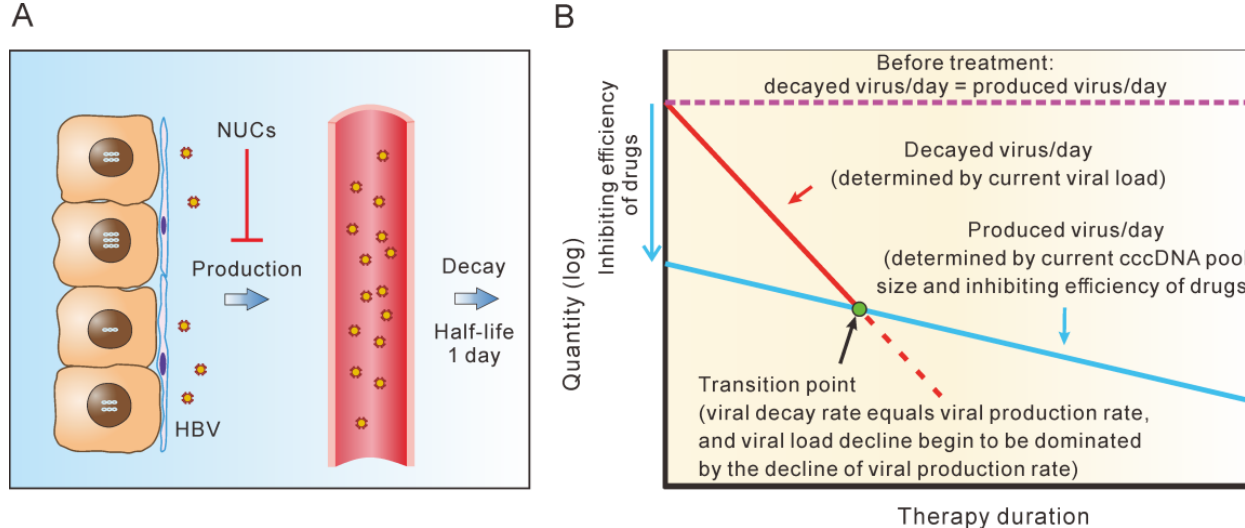
Figure 3. cccDNA decline is responsible for the second phase of serum viral load decrease during NUC therapy. ( A ) Serum HBV has a half-life of one day [17], and new viruses derived from the transcription of cccDNA replenish serum viral load during homeostasis prior to treatment. NUC treatment alters the balances in serum viral load and cccDNA pool size by inhibiting the production of new viruses [58]. ( B ) The serum HBV decay rate (amount of viruses that decay each day)